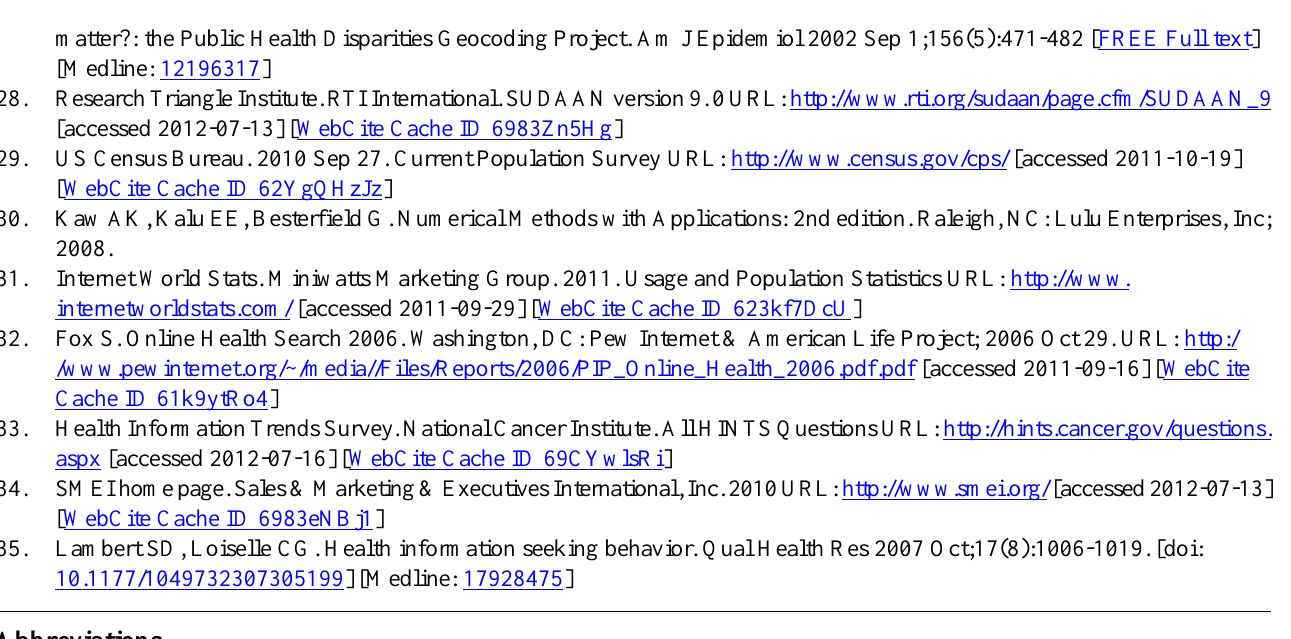
BRFSS: Behavioral Risk Factor Surveillance System HINTS: Health Information National Trends